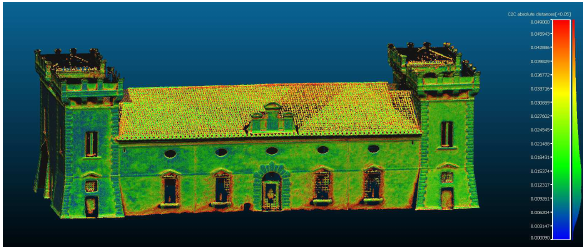
Figure 25: Comparison between photogrammetric point clouds and TLS one. Comparison made by CloudCompare (project made using all dataset simultaneously)